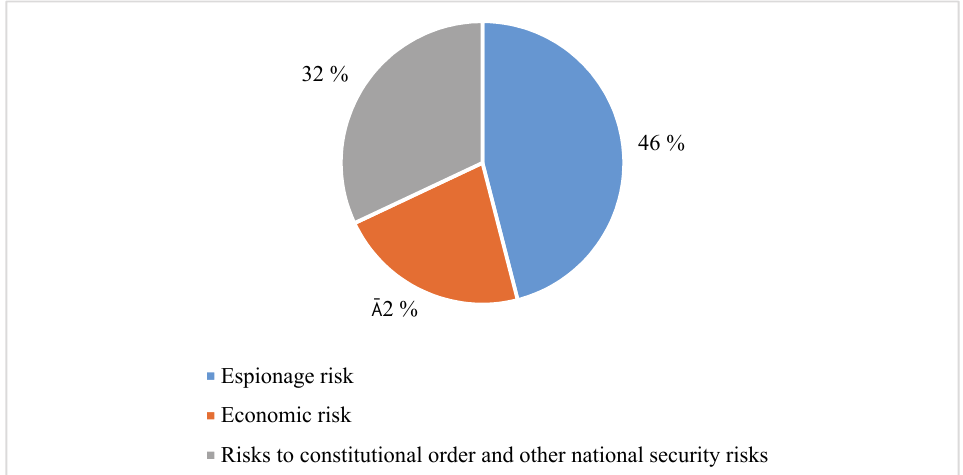
Fig. 7 . Reasons given for refusing or annulling temporary residence permits in Latvia in 2016 [developed by the authors based on the data from the Security Police of Latvia (Security Police,